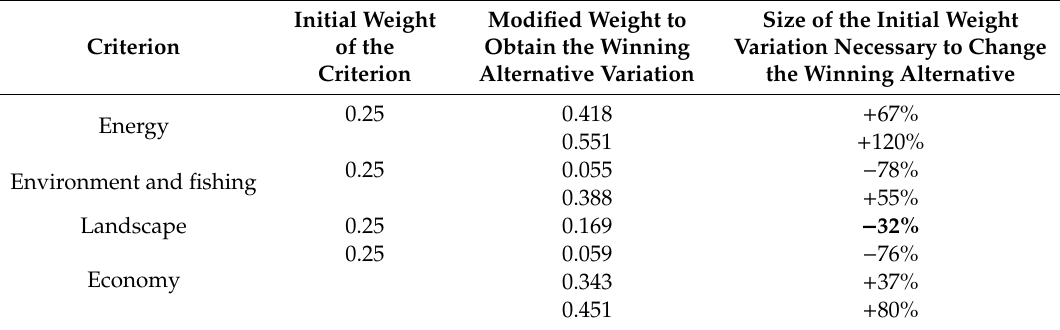
Table 3. Results of the sensitivity analysis carried out by varying the criteria weights for the Graines case study. In the final column, the size of the variation of initial weights necessary to change the winning alternative is shown: The variation is positive when the initial criteria weight was increased, while it is negative when the initial weight was reduced. Size of the Initial Weight Modified Weight to Initial Weight Variation Necessary to Change Obtain the Winning Criterion of the the Winning Alternative Alternative Variation Criterion Energy